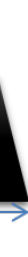
Figure 2. Blunted cone’s size (a: 5 mm, b: 2 mm, c: 7 mm).